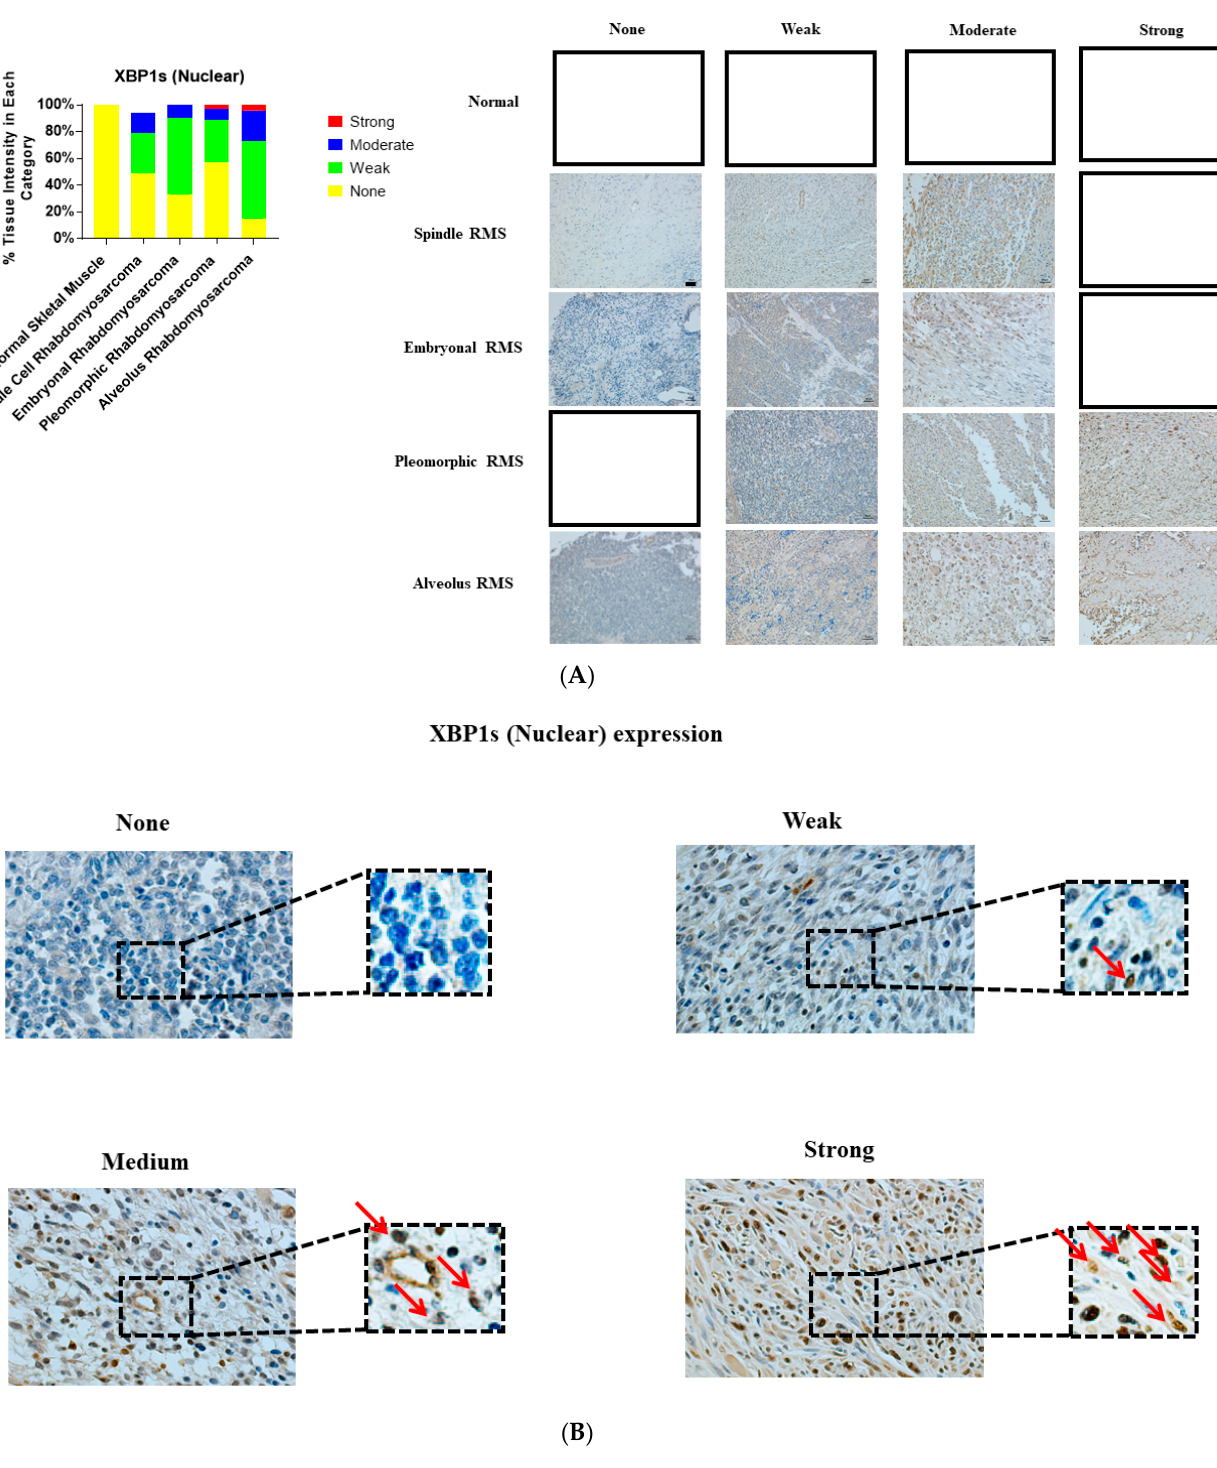
Figure 3. Immunohistochemical staining for sXBP1 in human skeletal muscle and RMS tissue. ( A , B ). We detected sXBP1 expression (red arrows) in human RMS TMA. Detailed information on the TMA was given in the Materials and Methods section. Three independent pathologists blindly evaluated the immunohistochemical sXBP1 expression (None = no staining; W: Weak staining; M: Moderate staining; S: Strong staining); the empty slots indicate that no samples matched the specifics of that group. Our results show that sXBP1 expression is associated with ARMS, ERMS, PRMS, and SRMS (Table 5). The scale bar refers to 50 µM.